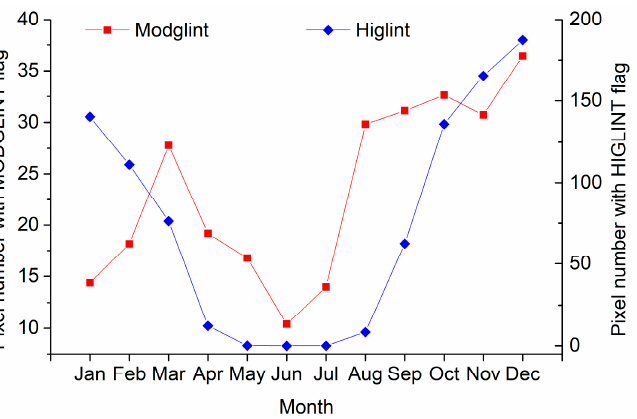
Figure 11. Pixel numbers of level 2 R rs ( λ ) with “MODGLINT” and “HIGLINT” flags corresponding to each level 3 pixel .